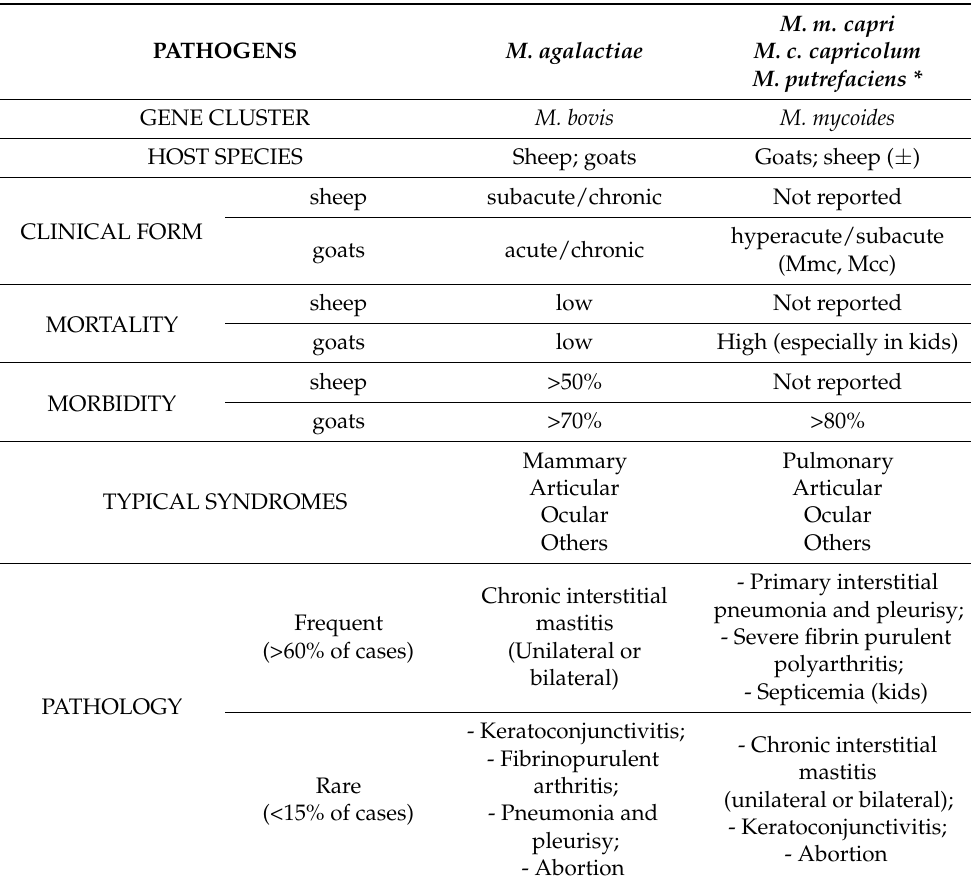
Table 1. Features of the contagious agalactia (CA) pathogens group.